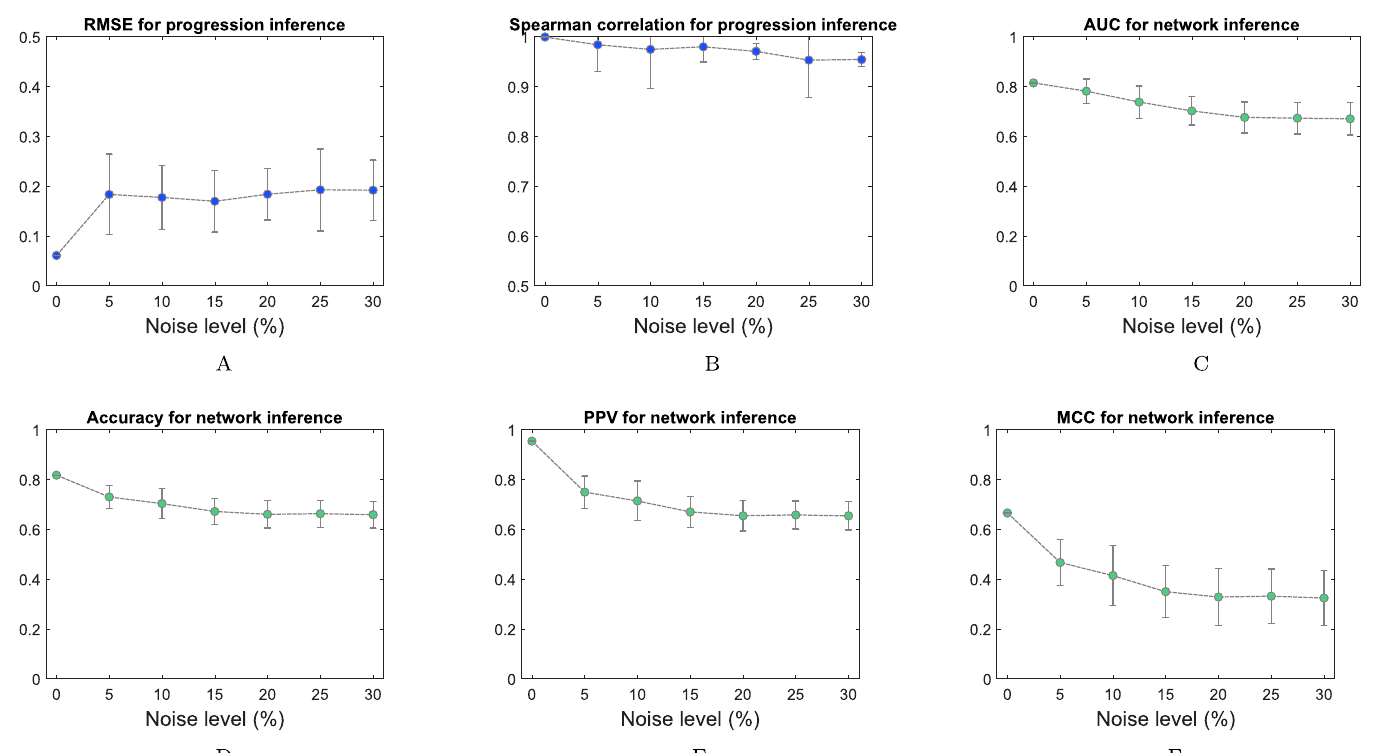
Fig 3. Evaluation metrics were used to verify the robustness of PCB against a series of variations in the data using multiplicative exponential noise (with CVs ranging from 0% to 30%). (A) and (B) The root mean square error (RMSE) and Spearman correlation coefficients were employed to evaluate the accuracy of the temporal progression inference. (C),(D),(E) and (F) The AUC, accuracy, positive predictive value (PPV) and Matthews correlation coefficient (MCC) were employed to evaluate the robustness of the reconstructed regulatory relationships between alternative splicing events and RNA-binding proteins.